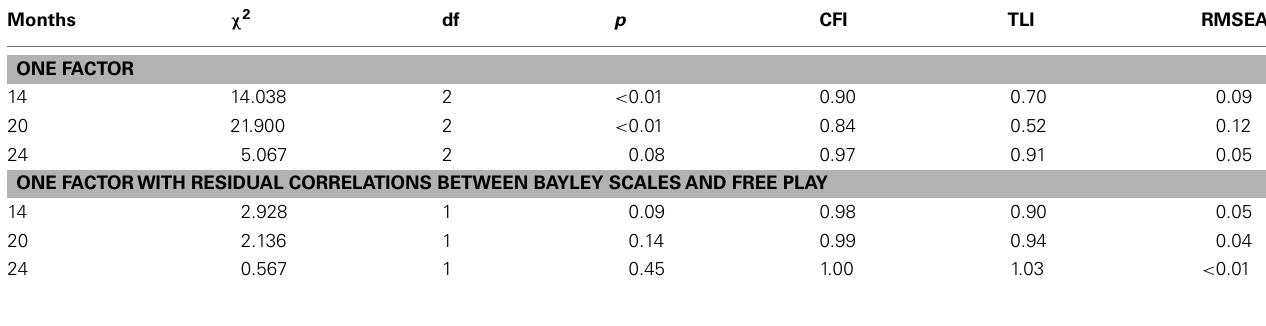
Table 5 | Model fitting results for confirmatory factor analyses of observed negative emotionality